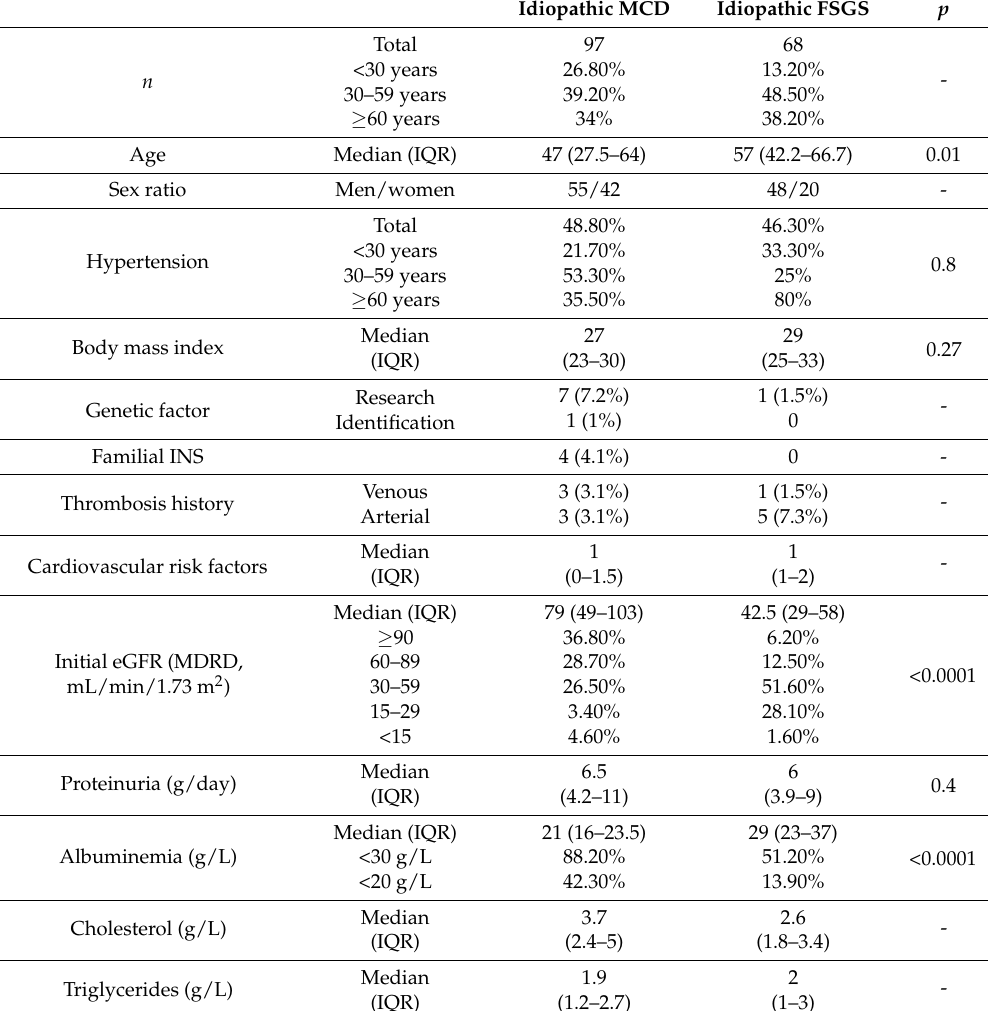
FSGS, focal segmental glomerulosclerosis; MCD, minimal change disease; IQR, interquartile range; eGFR, estimated glomerular filtration rate; MDRD, modification of diet in renal disease; INS, idiopathic nephrotic